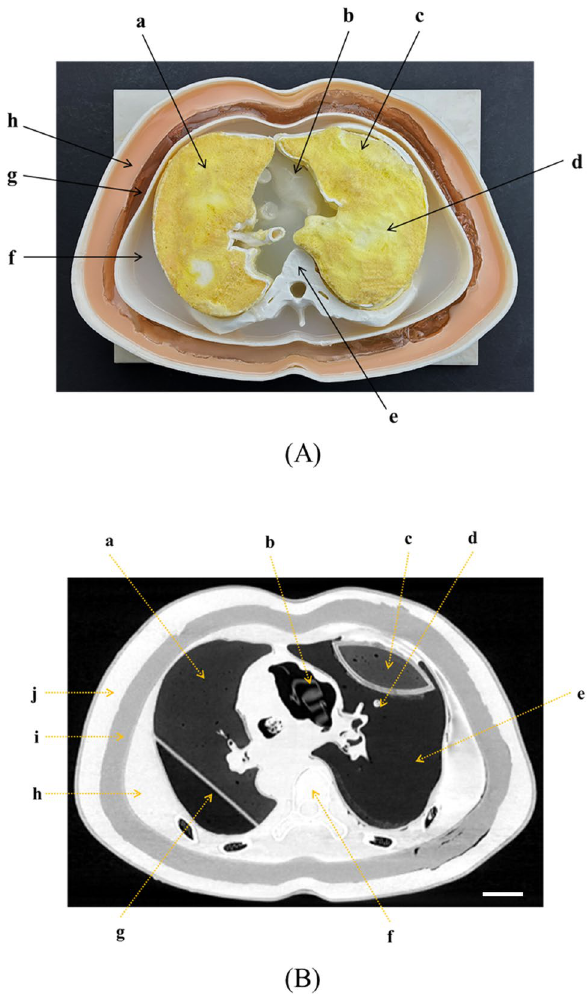
Figure 4. 3D printing image phantom and CT image. ( A ) Fabrication of the chest phantom using 3D-printing technology (a, emphysema; b, heart; c, fibrosis; d, normal lung parenchyma; e, spine and rib; f, muscle; g, fat; and h, skin), and ( B ) CT image of the phantom (a, emphysema; b, heart; c, fibrosis; d, solid nodule; e, normal lung parenchyma; f, spine and rib; g, fissure; h, muscle; i, fat; and j, skin). CT, computed tomography; 3D, three-